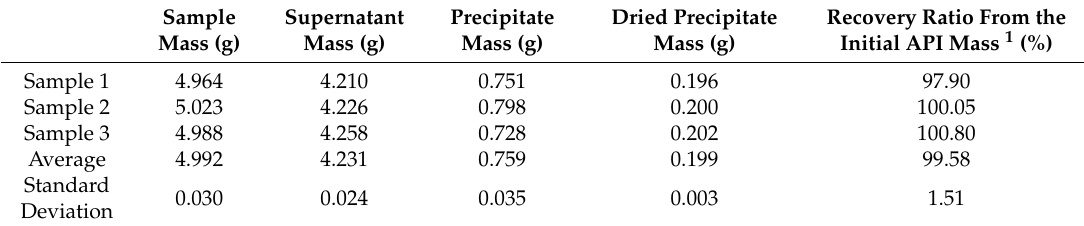
Table 2. Mass of water dispersion, separated supernatant, recovered precipitate and recovered dried precipitate as well as the recovery ratio of the Posaconazole API after centrifugation of Posaconazole water dispersion in triplicates.